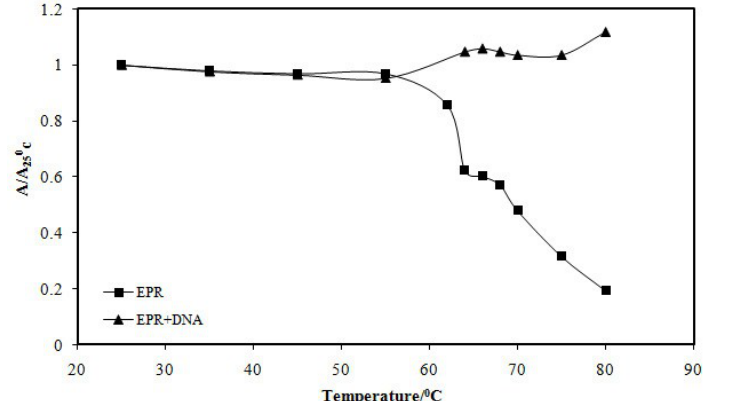
Figure 6. Melting curves for EPR in the absence and presence of ds-DNA at wavelength ＝ 10.0 μmol L -1 and c ＝ 50.0 μmol L -1 in phosphate buffer (0.1 mol L -1 , pH 482 nm. C EPR DNA